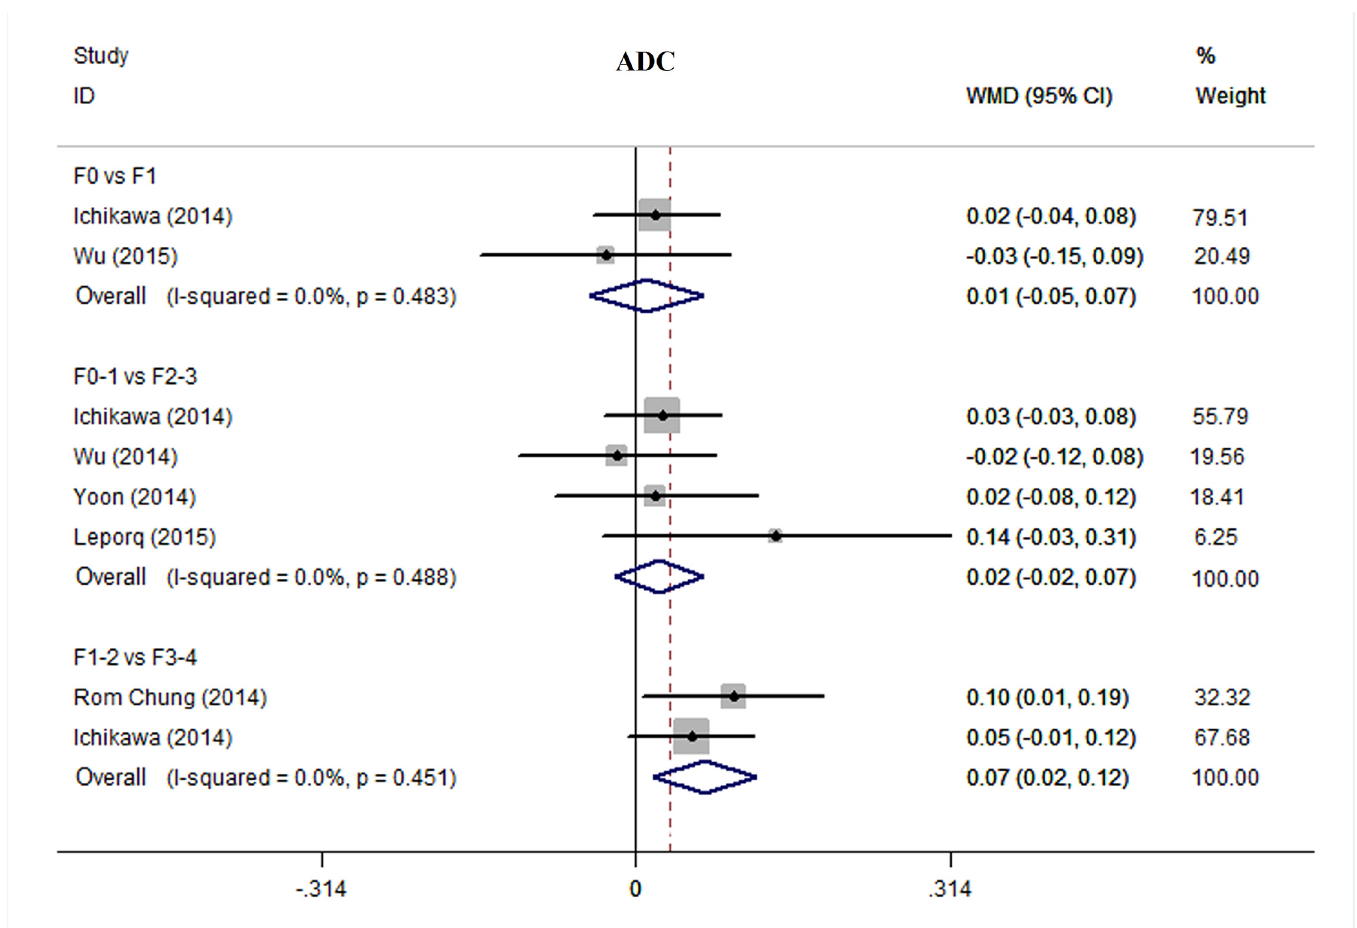
Fig 6. Comparing stage F0 with F1, F0-1 with F2-3, and F1-2 with F3-4 using ADC. We used influence analysis to drop a study exerted excessive influence on the overall estimate and therefore to decrease the heterogeneity. Abbreviations: WMD = weighted mean difference; CI = confidence